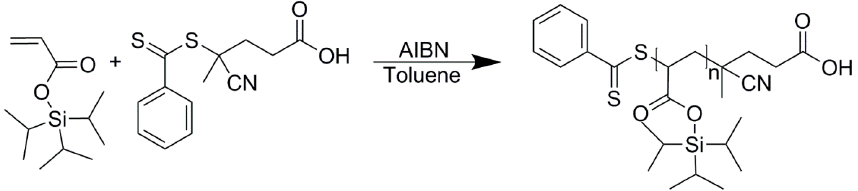
Figure 1. Synthesis of polymerized triisopropylsilyl acrylate (PTIPSA) by reversible addition–fragmentation chain transfer (RAFT) polymerization.